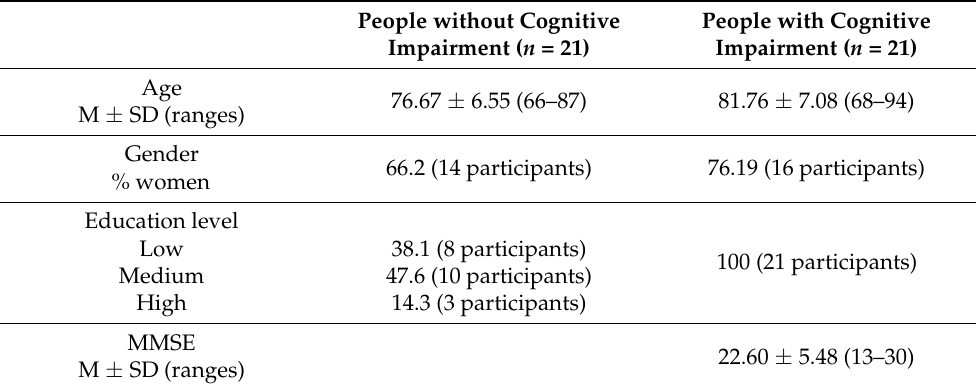
Table 1. Demographic characteristics of the subjects. M ± SD indicates the mean ± standard deviation. Education level (low: no studies or primary studies; medium: high school or equivalent; high: university studies or